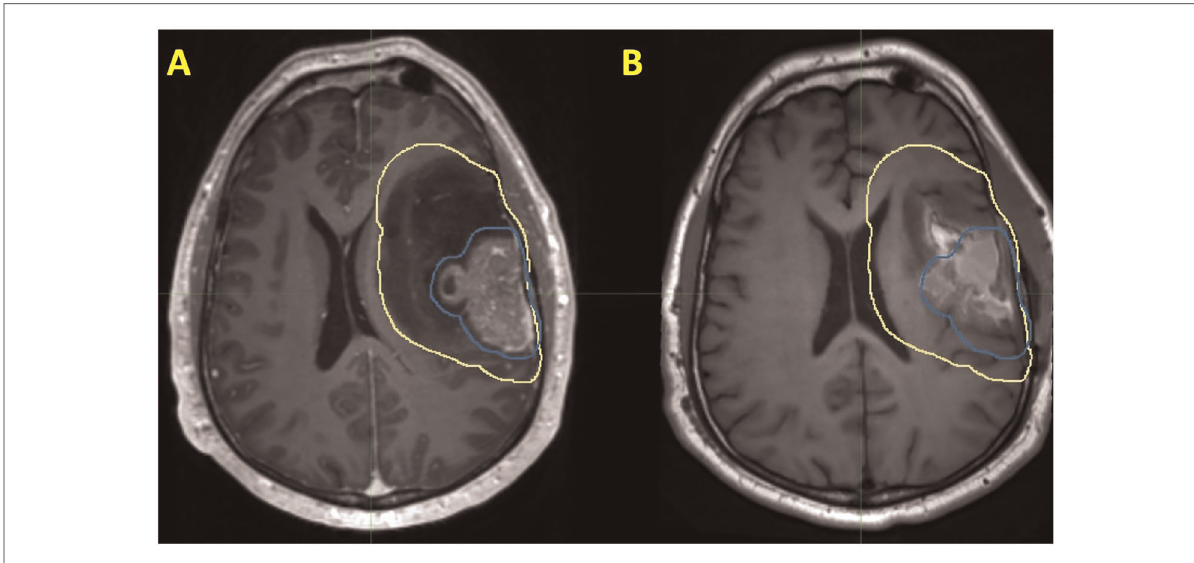
FIGURE 3 Patient with a history of glioblastoma, where the volume encircled in blue represents a preoperative SRS volume and the volume encircled in yellow represents a postoperative radiotherapy volume. Each of these volumes are shown on ( A ) preoperative T1 post contrast MRI and ( B ) T1 postoperative T1 post contrast